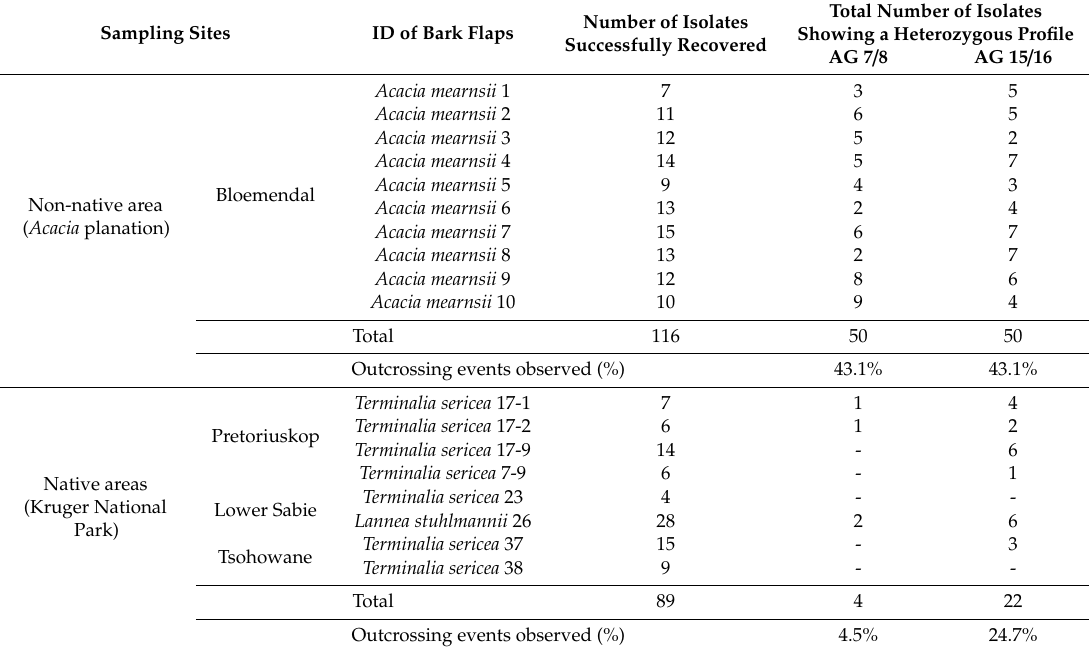
Table 3. The estimated outcrossing frequency of Ceratocystis albifundus in Bloemendal area (KZN) and Kruger National Park